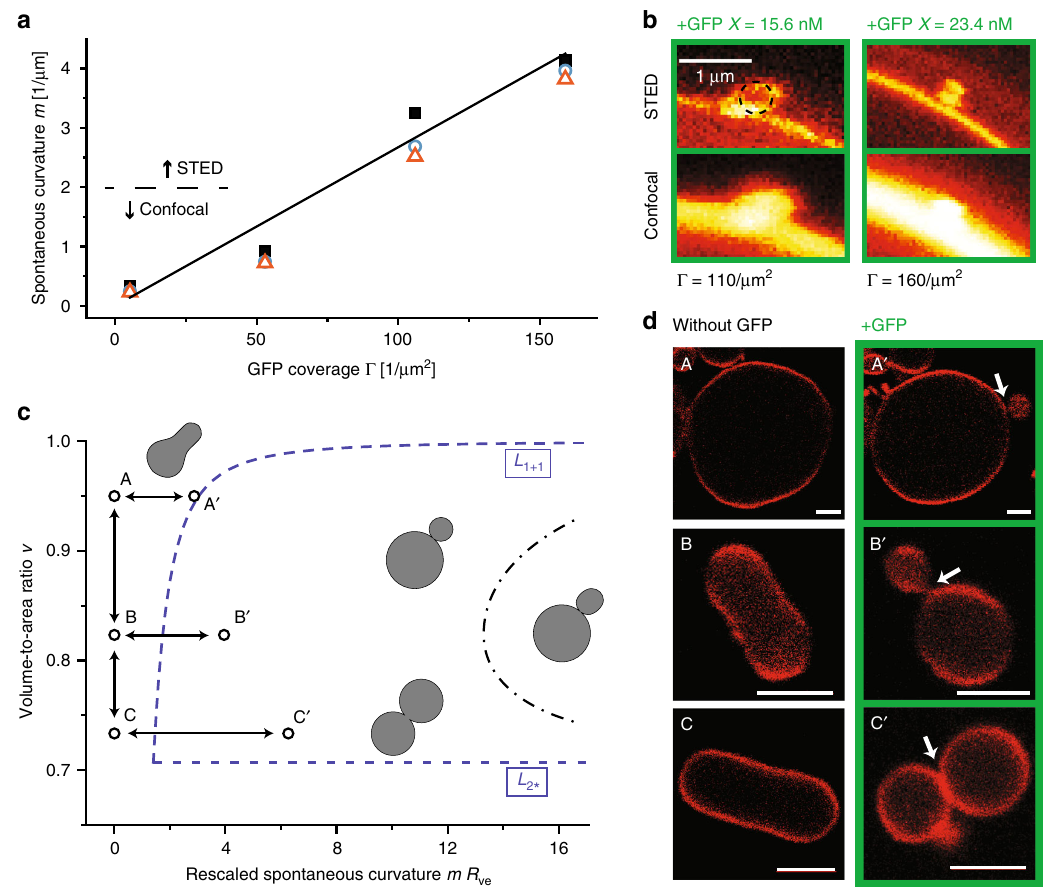
Fig. 2 Spontaneous curvature and morphology diagram. a Spontaneous curvature m generated by GFP coverage Γ : We studied four vesicle populations with four different GFP coverages as obtained for 0.1 mol% anchor-lipids and molar GFP concentrations X = 0.78, 7.8, 15.6, and 23.4 nM. For the two lower concentrations X = 0.78 and 7.8 nM, the dummbell-shaped vesicles were imaged by confocal microscopy, whereas we used STED microscopy to resolve the small buds formed for the higher concentrations X = 15.6 and 23.4 nM. For each vesicle population, we selected the three vesicles with the largest neck curvature M ne as de fi ned in Eq. (5) from at least three independent experiments. These three curvature values provide the three data points (black squares, red triangles, green circles) included for each Γ -value. The straight line represents the least-squares fi t through the black squares and has a slope of about ’ 0 : 98). b Confocal and STED images of small buds as obtained for GFP concentrations X = 15.6 and 23.4 nM. For the analysis of the STED 27 nm ( R 2 adj images, see Supplementary Fig. 2. c Morphology diagram as a function of two dimensionless shape parameters, the rescaled spontaneous curvature mR ve and volume-to-area ratio v . Dumbbell-shaped vesicles with a closed membrane neck are found between the two dashed lines L 1 + 1 and L 2* (blue). The latter subregion contains the dash-dotted line, at which the spherical buds become unstable and transform into prolate buds. The shapes denoted by A, B, and C correspond to three GUVs in the absence of GFP. Adding GFP to the exterior solution, the three GUVs transformed into the dumbbell shapes A 0 , B 0 , and C 0 . d Confocal images of the six vesicle shapes A, B, and C (left column) as well as A 0 , B 0 , and C 0 (right column). The white arrows indicate the positions of the closed membrane necks. The corresponding parameter values are displayed in Table 1. All scale bars: 5 μ m. Source data for panels a and c are provided in the Source Data fi